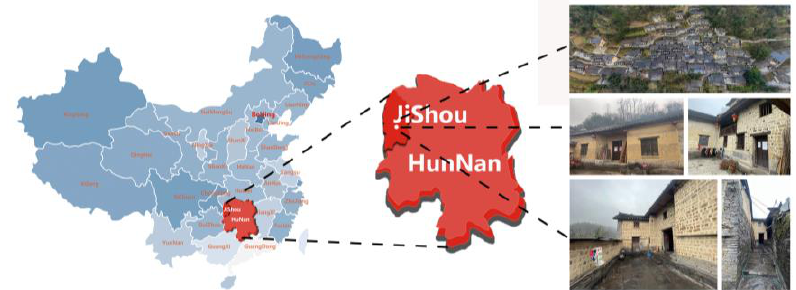
Figure 1. Location and environment of raw earth dwelling in south of Hunan, China.